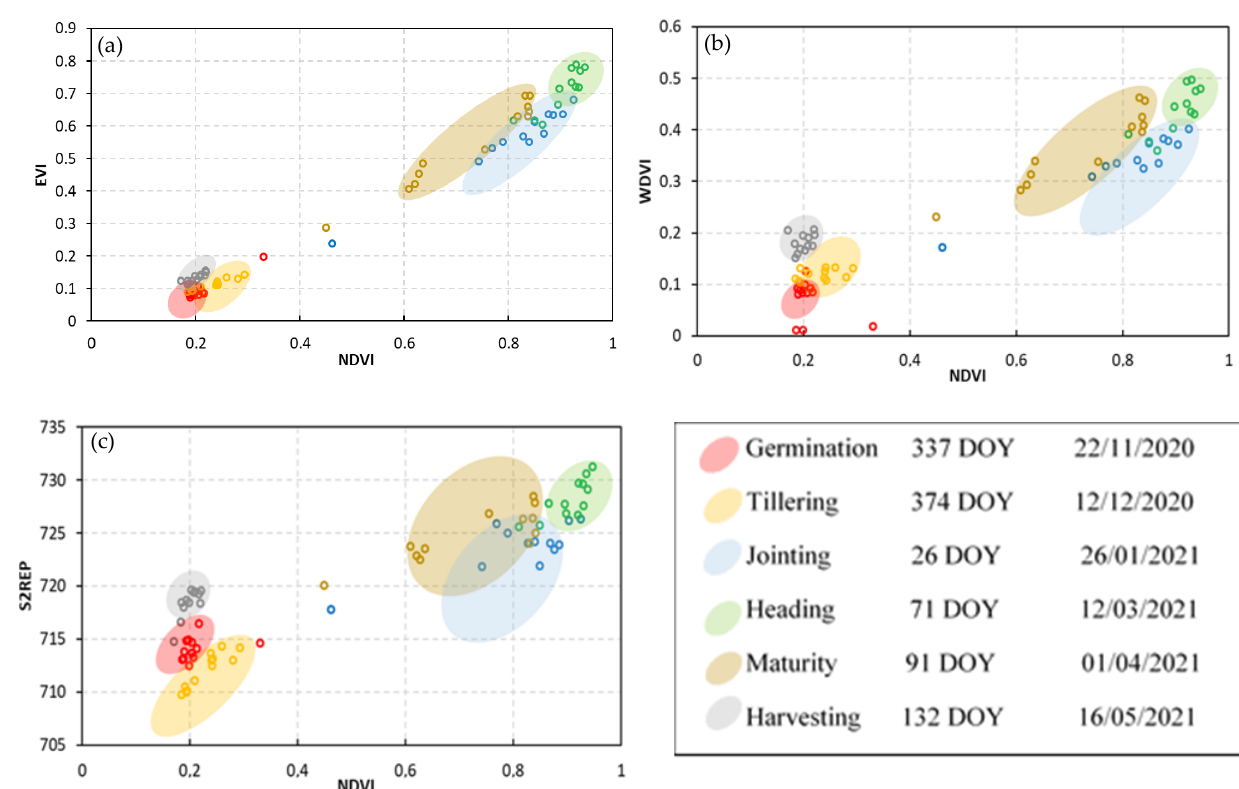
Figure 8. The scatterplot of the field samples of the wheat plots in a space including the NDVI and EVI ( a ), NDVI and WDVI ( b ), NDVI and S2REP ( c ) for the different dates of wheat stages. The germination stage was more accurately identified using the NDVI and S2REP combination, as the wheat plots showed low NDVI and S2REP values (<0.2 and <715). In the tillering period, the NDVI and S2REP values were discriminated, with the wheat plots showing greater NDVI values (from 0.2 to 0.3) and lower S2REP values (from 710 to 715) than during germination. Using the NDVI and WDVI space combination, the jointing phase was accurately identified. The NDVI and S2REP values for the heading period were distinct, with wheat plots having higher NDVI and S2REP values (>0.8 and >725). The maturity period was discriminated with the NDVI and WDVI space combination. When the crop is mature physiologically, the NDVI and WDVI as well as the NDVI and S2REP space combination, assisted to distinguish the harvesting